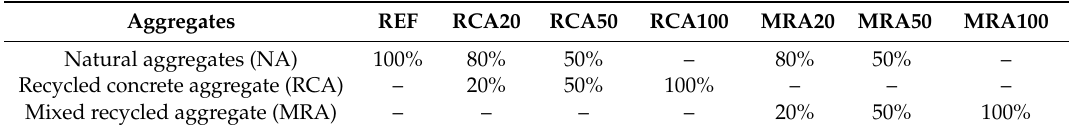
Table 1. Mortar mixes identification.